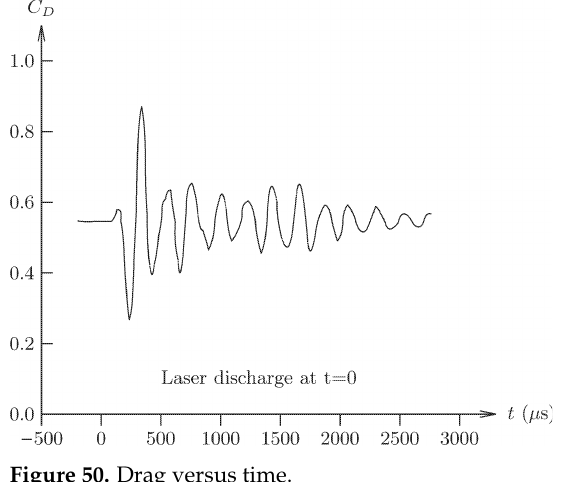
Figure 50. Drag versus time.